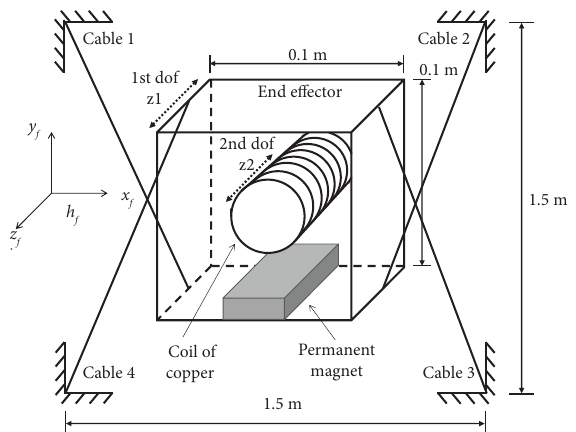
Figure 1: Diagram of the planar CDPR and the ETMD inside the end efector, elements that represent two degrees of freedom in the z f